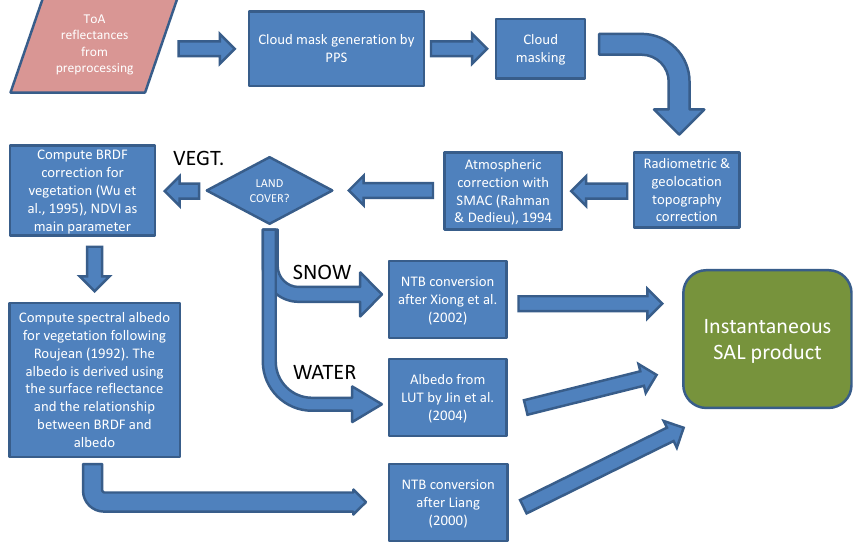
Fig. A1. The SAL algorihm process as a flowchart.